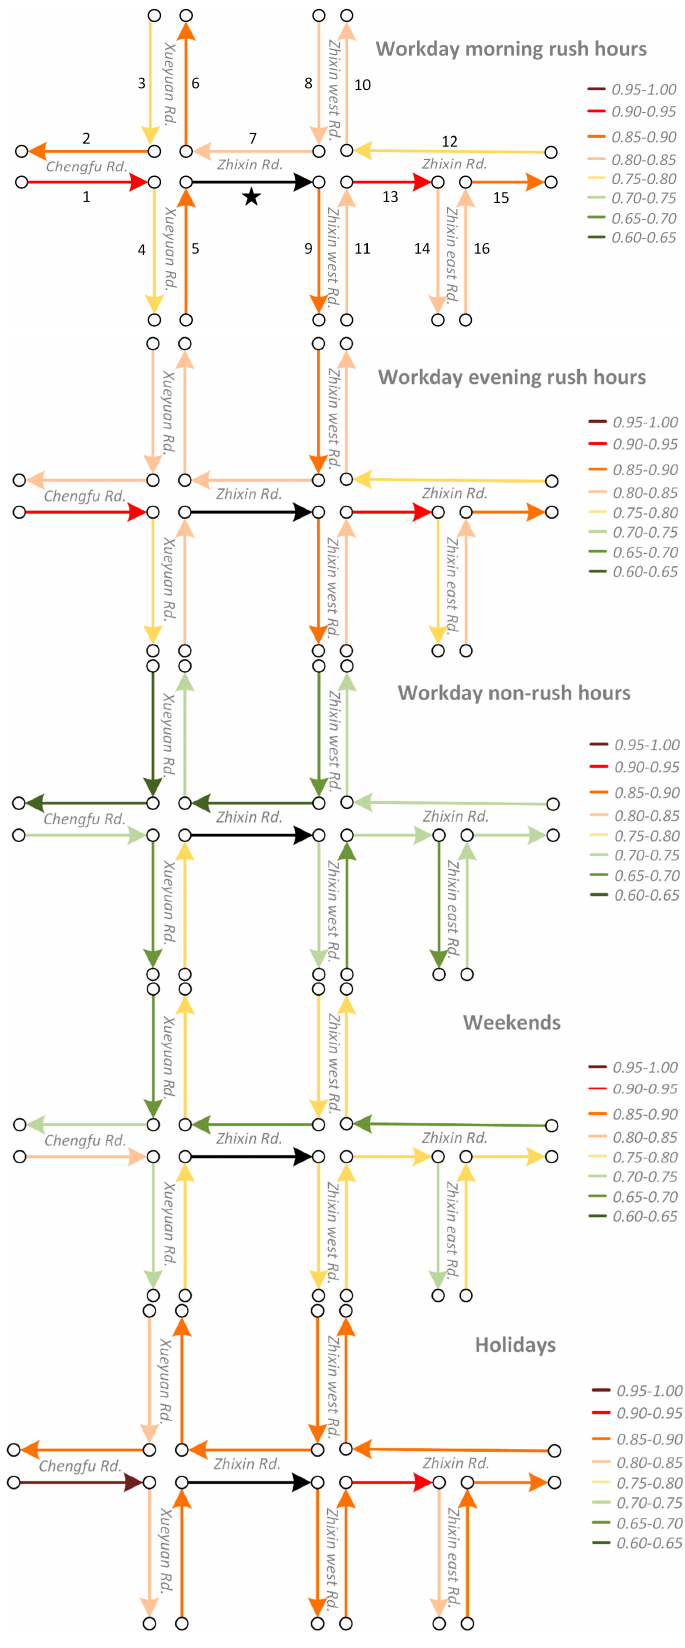
Figure 3. Traffic interactions between a road segment and its neighbors.